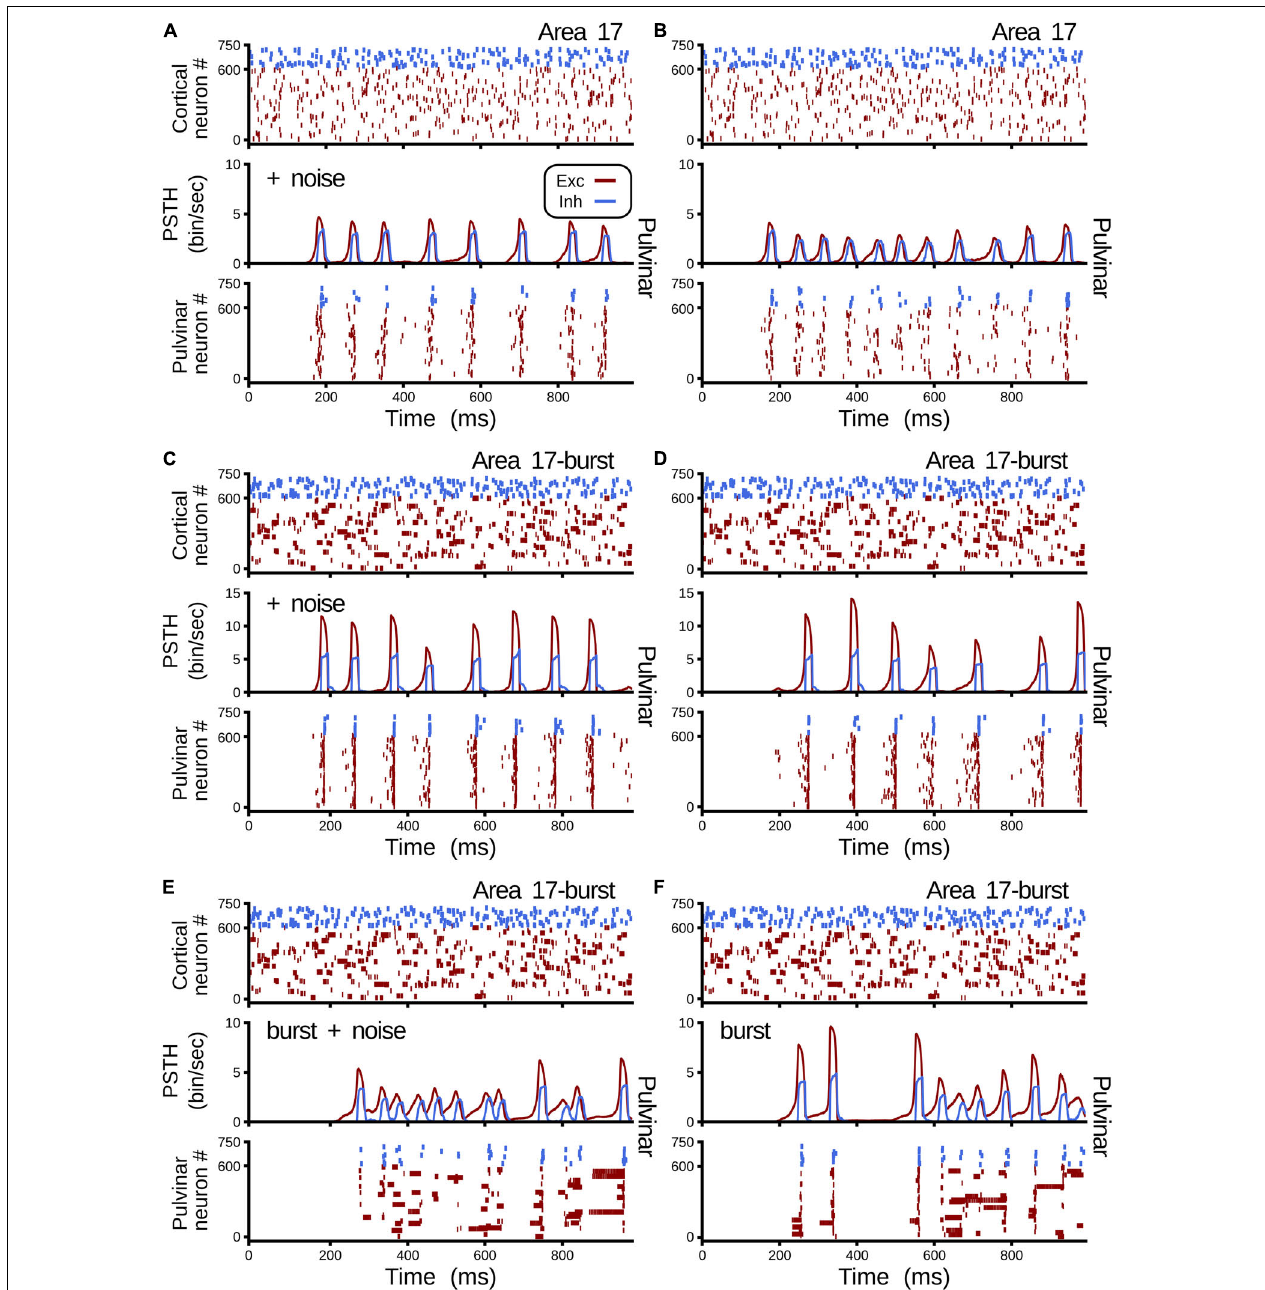
FIGURE 9 | Combinations of cases when area 17 and pulvinar neurons have regular or burst discharges, and pulvinar is with or without background synaptic noise. For each case, raster plots for area 17 and pulvinar and PSTH for pulvinar are shown. Case (A) Regular spiking for area 17 and pulvinar neurons, background synaptic noise added to pulvinar neurons. Case (B) Similar to case (A) , but without background synaptic noise in pulvinar. Case (C) Bursting dynamics for area 17, regular spiking for pulvinar neurons, background synaptic noise added to pulvinar neurons. (D) Similar to case (C) , but pulvinar neurons without background synaptic noise. (E) Bursting dynamics for area 17 and pulvinar neurons, background synaptic noise added to pulvinar neurons. (F) Similar to case (E) , but pulvinar neurons without background synaptic noise. Supplementary Table 2 shows values of η a 17 1 and η a 17 2